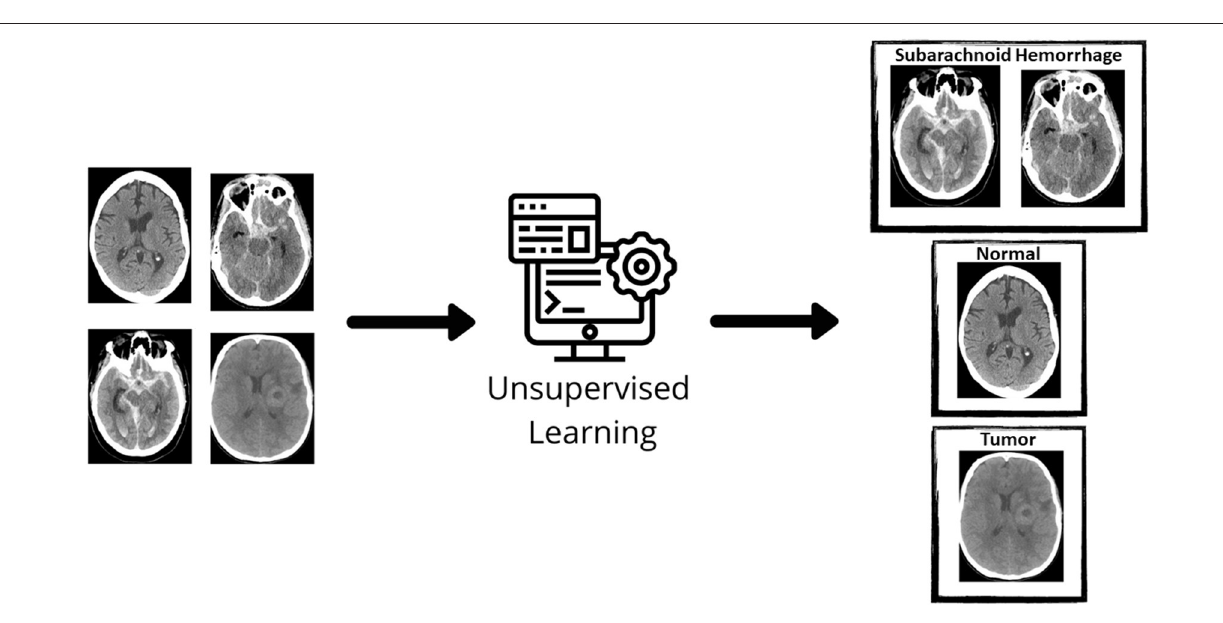
segmentation of lesion volume and mismatch